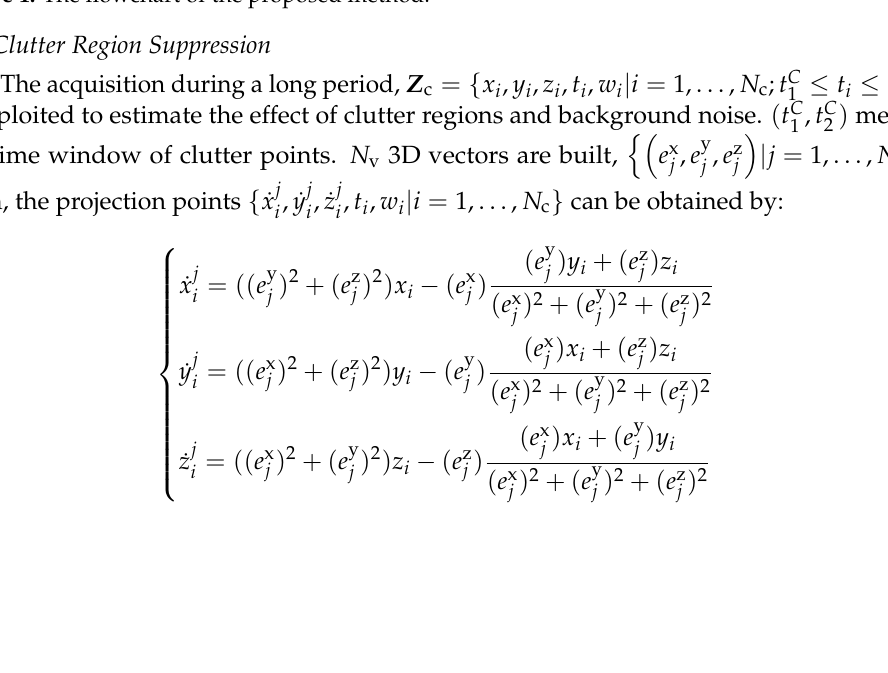
Figure 1. The flowchart of the proposed